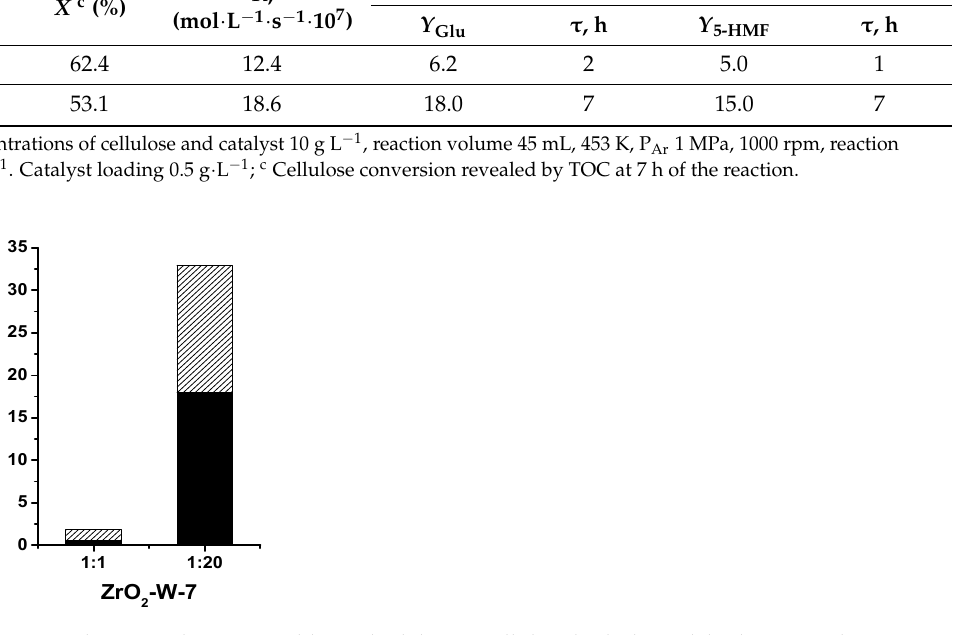
Figure 3. Glucose and 5-HMF yields reached during cellulose hydrolysis-dehydration in the presence of ZrO 2 -W-7 catalyst. Reaction conditions: initial concentration of cellulose 10 g L − 1 , initial catalyst loading 10 (0.5) g L − 1 , reaction volume 45 mL, 453 K, P Ar 1 MPa, 1000 rpm, reaction time 7